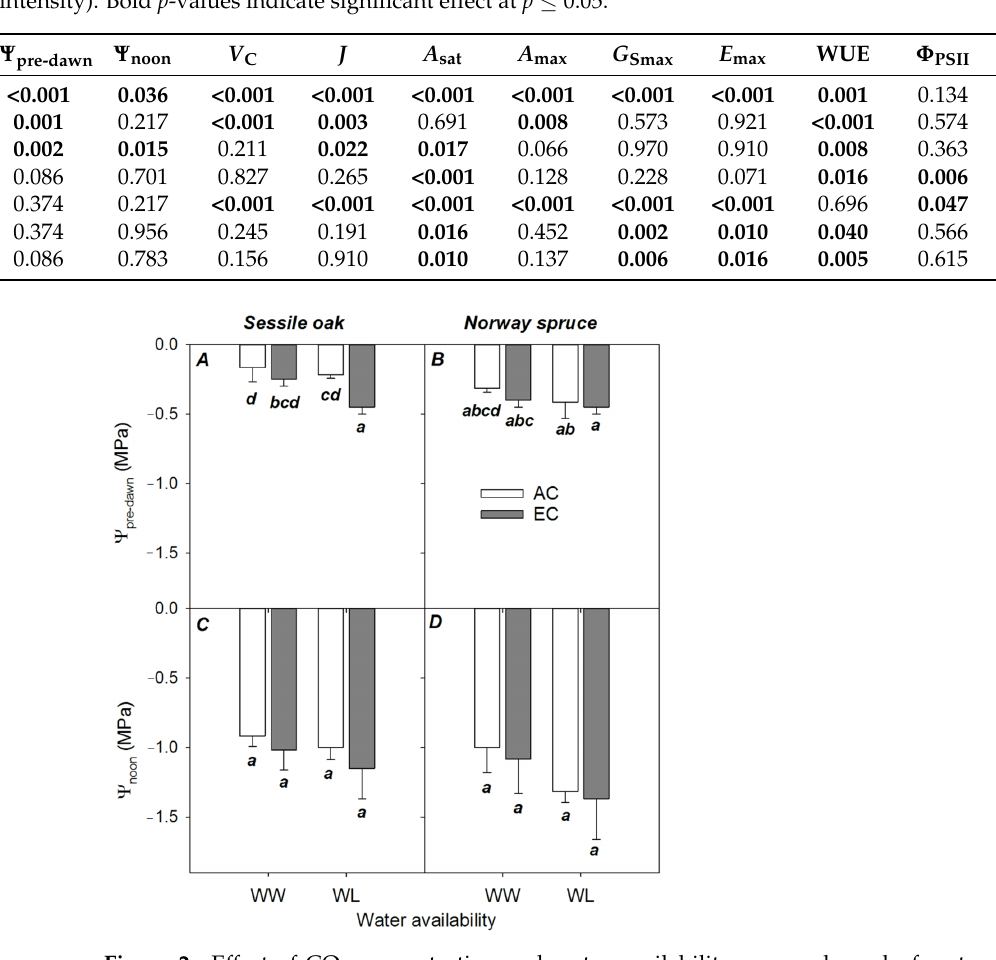
Figure 2. Effect of CO 2 concentration and water availability on pre-dawn leaf water potential ( Ψ pre-dawn ) and noon leaf water potential ( Ψ noon ) in sessile oak (left) and Norway spruce (right). Means (columns) and standard deviations (error bars) are presented ( n = 3). Different letters indicate significant differences ( p ≤ 0.05) between means based on Tukey’s ANOVA